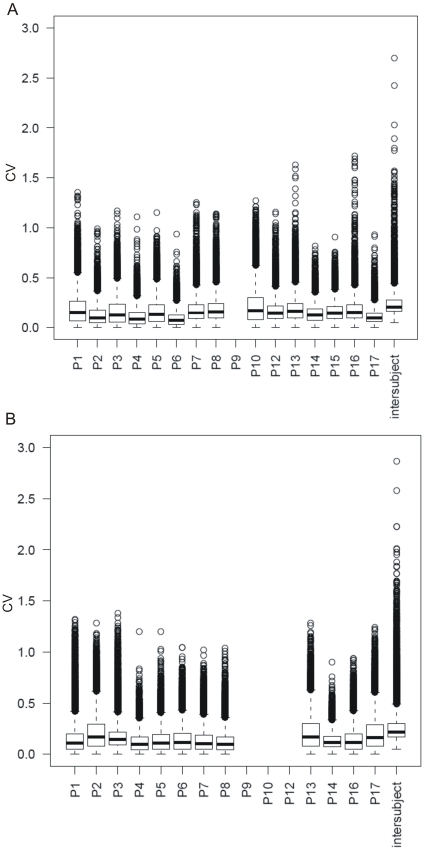
Intra-individual variability in gene expression compared to inter-individual variability.Variabilities are represented as boxplots of gene expression CV for each individual and in complete dataset. A) CD4+ T and B) NK cells. For subject P9 this evaluation was not possible for CD4+ T cell dataset as only one sample out of the three passed the technical quality control in all steps of the procedure. The same was true for subjects P9, P13 and P12 in NK cells dataset.